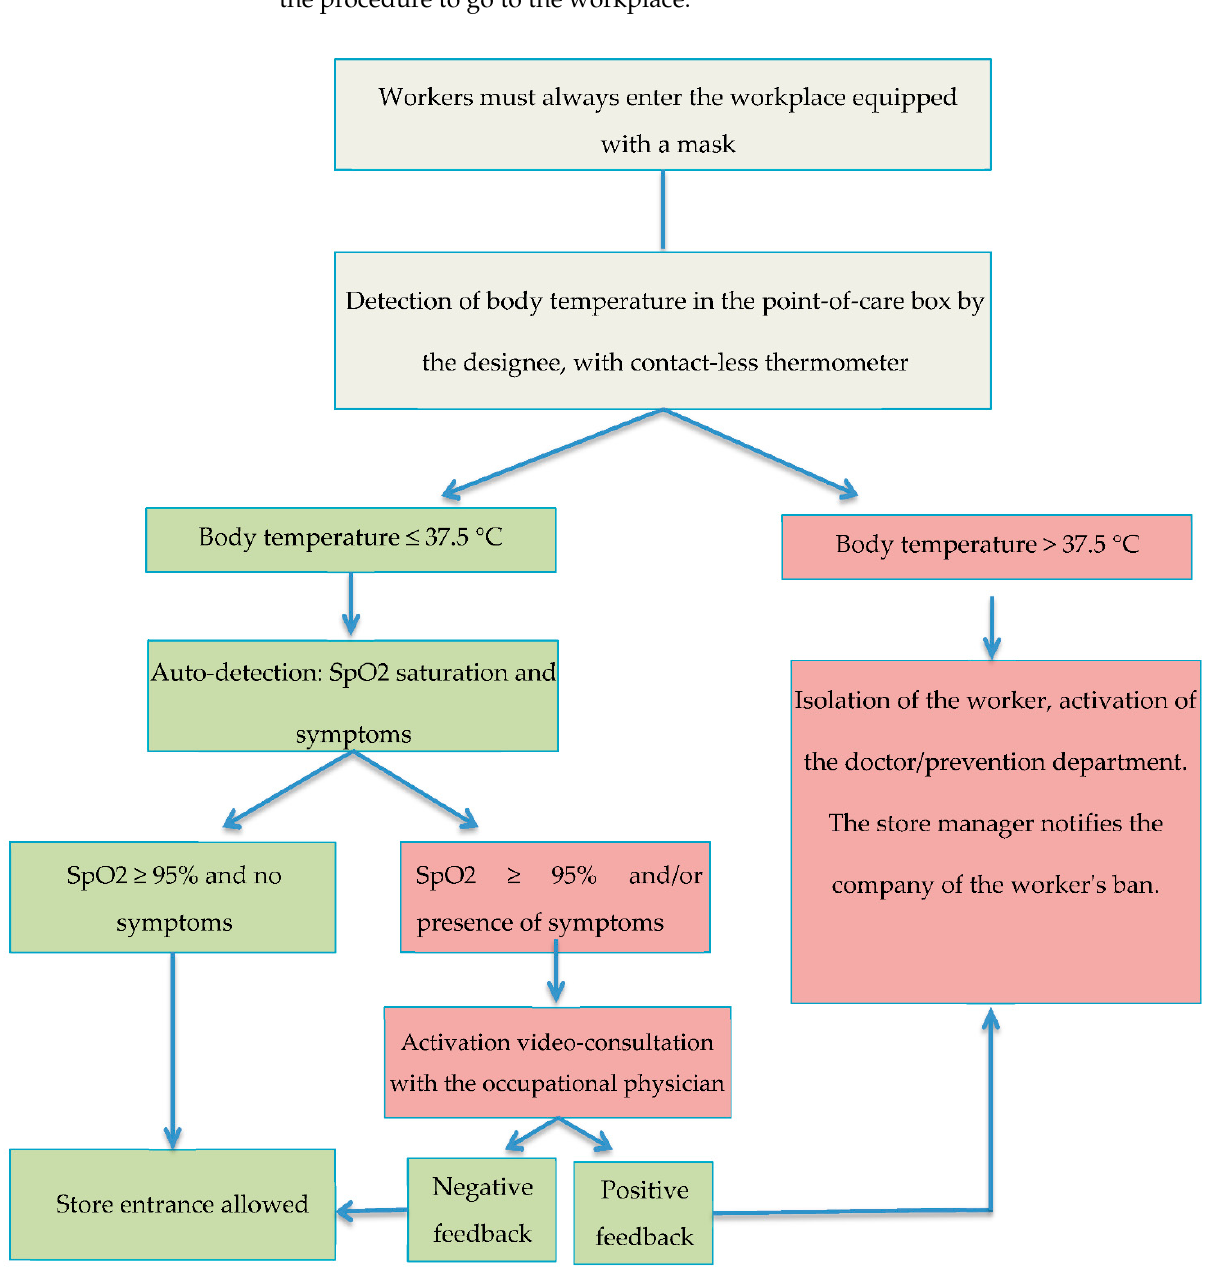
Figure 1. Flow chart with anti-COVID-19 procedures to be followed when entering the company.